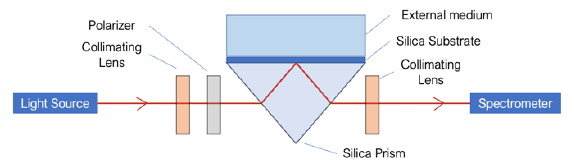
Fig. 1. Experimental setup based on the Kretschmann configuration for ESW